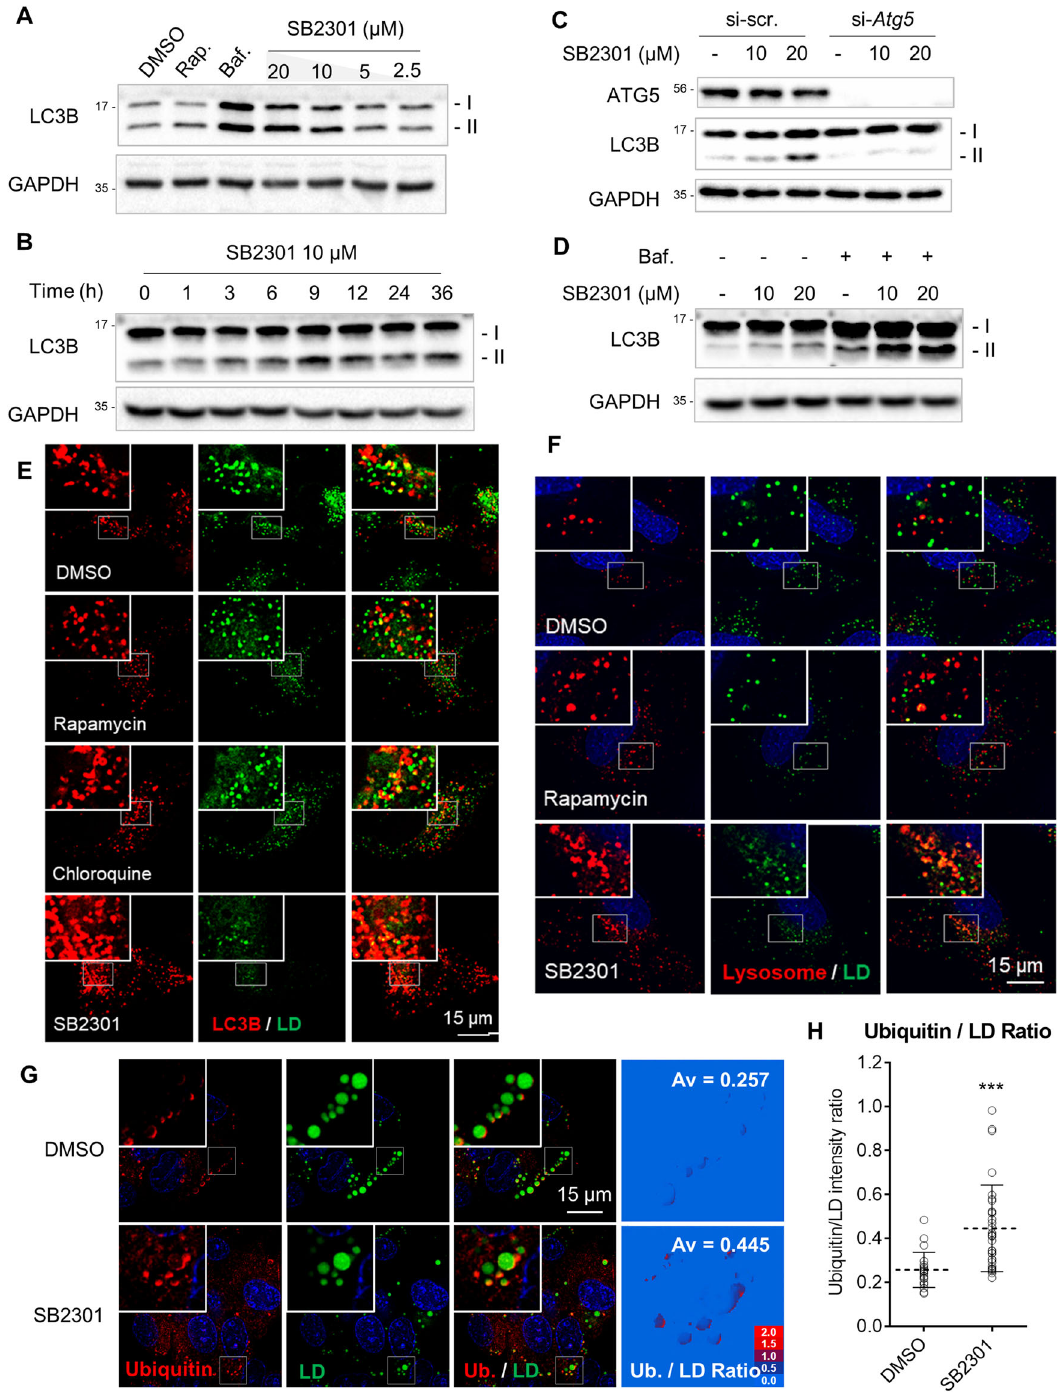
Fig. 2 SB2301 reduces cellular LDs via lipophagy. A Western blot analysis with various doses of SB2301, rapamycin (Rap, 2 μ M), and ba fi lomycin A1 (Baf, 20 nM) treated in HepG2 cells for 12 h. Western blot analysis with 10 μ M of SB2301 for indicated times ( B ), with SB2301 treatment under the autophagy related gene 5 ( Atg5 )-knockdown condition, followed by SB2301 treatment for 9 h ( C ), and with SB2301 treatment in the absence and presence of 5 nM of Baf for 6 h ( D ). E Representative live-cell fl uorescence images of LC3 (red, mCherry) and LDs (green, SF44) on mCherry-LC3 transfected HeLa cells upon treatment with rapamycin (1 μ M), chloroquine (10 μ M), and SB2301 (5 μ M) for 12 h. F Representative live-cell fl uorescence images of lysosomes (red, lysotracker) and LDs (green, SF44) upon treatment with rapamycin (1 μ M) and SB2301 (10 μ M) on HeLa cells for 12 h. G Representative immuno fl uorescence images of ubiquitin (red) and LDs (green, BODIPY 493/503) on HepG2 cells upon SB2301 treatment (10 μ M) for 12 h. After cells were fi xed, ubiquitin was labeled with anti-ubiquitin antibody and LD was stained with BODIPY 495/503. H Fluorescence intensity quanti fi cation of images captured in G . Images were selected randomly from biological triplicates ( n = 21 from DMSO, n = 32 from SB2301). Cytoplasmic ubiquitin signals were subtracted as a background, and the fl uorescent signal ratio (ubiquitin/LD) on each pixel was calculated. All data are represented as dot plots with the mean ± SD. Data were analyzed using an unpaired t -test. *** P =